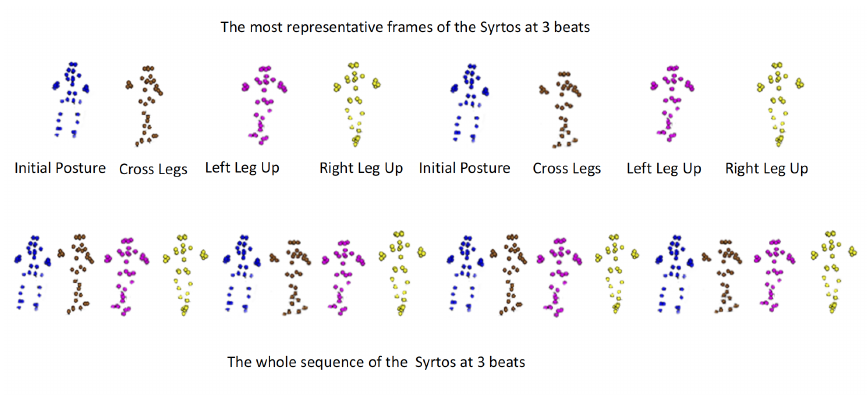
Figure 13. The most representative postures of the Syrtos at 3 beats dance. Each posture is depicted with different color indicating the keyframes of the folklore dance. These postures summarize the whole choreographic